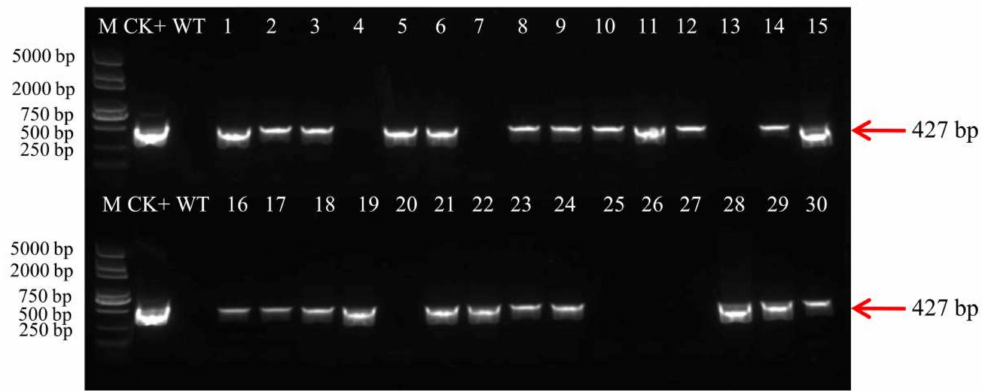
Figure 3. Detection of T1 transgenic plants by PCR. PCR analysis of genomic DNA of T1 transgenic plants using bar gene primers. The length of PCR product is 427 bp. M: DL2000 Plus; CK+: plasmid DNA; WT: wild-type soybean plant; lanes 1–7: T1 lines (line 1-1, line 1-2, line 2-1, line 3-1, line 3-3, line 3-4, line 4-1) versus 1–4 T0 lines from treatment without L -amino acid;lanes 8–15: T1 lines (line 6-1, line 6-2, line 7-1, line 7-2, line 7-3, line 7-4, line 7-5, line 8-1) versus 6–8 T0 lines from treatment with L -asparagine;lanes16–20: T1 lines (line 11-1, line 12-3, line 13-2, line 14-5, line 15-1)versus 11–15 T0 lines from treatment with L -glutamine;lanes21–30: T1 lines(line 16-1, line 17-1, line 17-2, line 17-9, line 17-10, line 17-11, line 17-12, line 17-14, line 18-5, line 19-10) versus 16–19 T0 lines from treatment with both L -asparagine and L -glutamine).